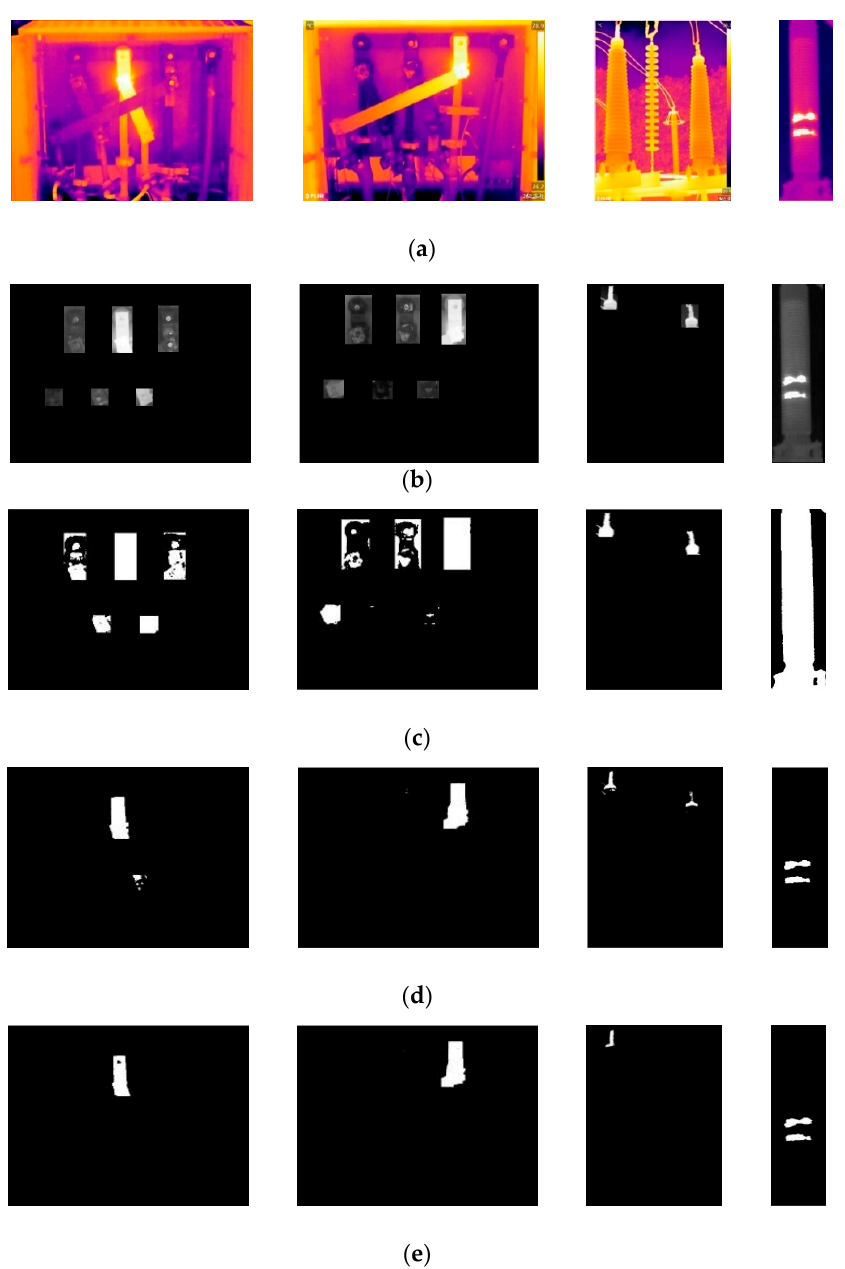
Figure 11. Results of extracting the suspected abnormal heating regions: ( a ) original infrared images, ( b ) detecting results of diagnostic objects by Faster RCNN network, ( c ) extracting results of the OTSU algorithm, ( d ) extracting results of the K-Means algorithm, ( e ) extracting results of the Mean- Shift algorithm.